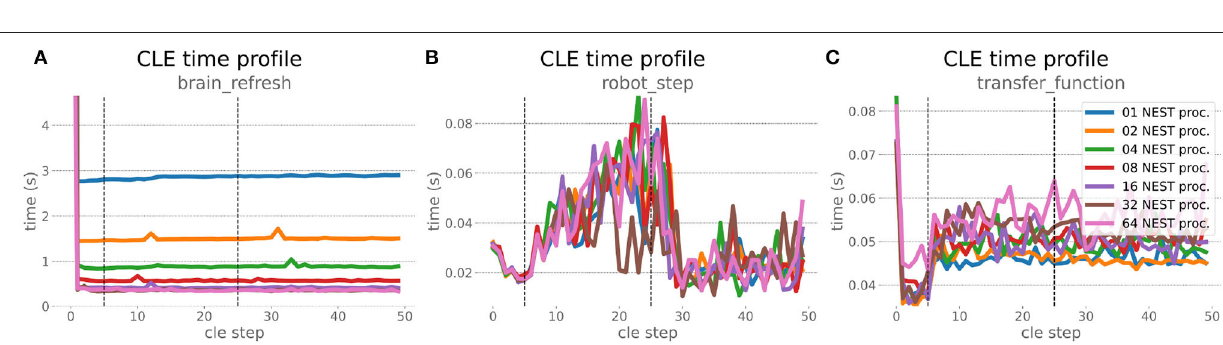
FIGURE 11 | Embodied multi-region rodent brain benchmark NEST times and workload manager characteristics. NEST network building time (A) scales up close to linearly, NEST simulation time (B) nearly optimally linearly. Building time and simulation time shorten by factors of about 17 and 30, respectively. The required memory per node (C) for running the experiment scales close to linearly, but the total amount of consumed energy (D) only increases by a factor of about 12.